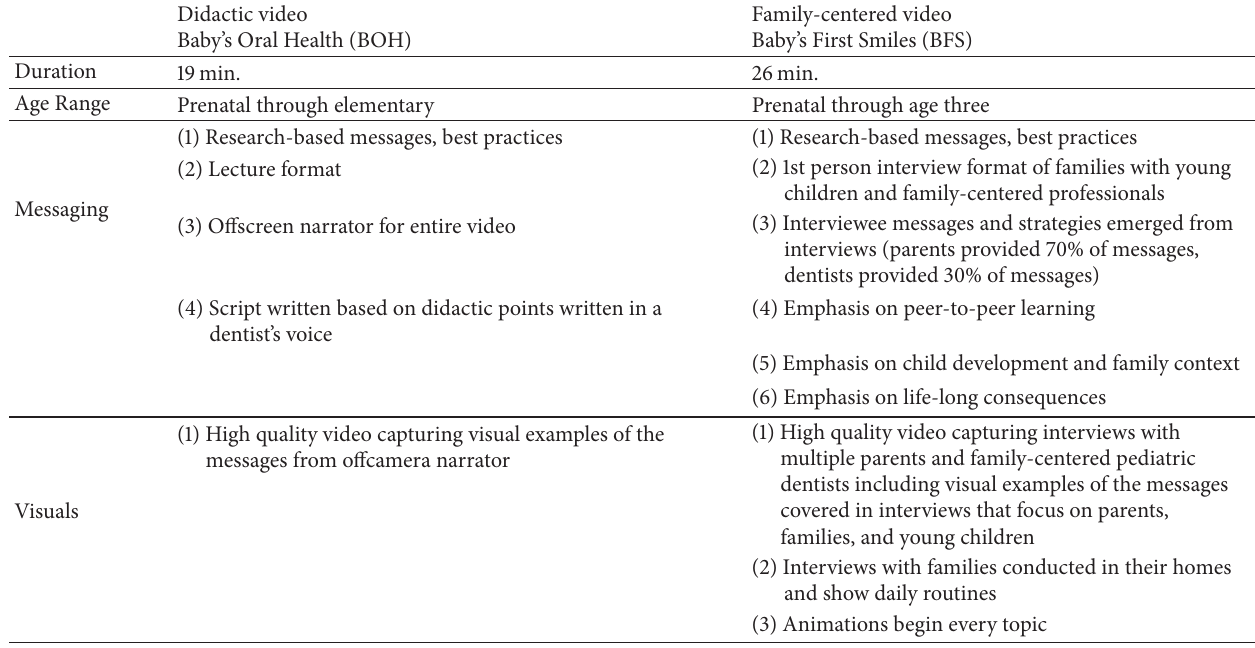
Table 1: Features of the Baby’s Oral Health and Baby’s First Smiles videos.